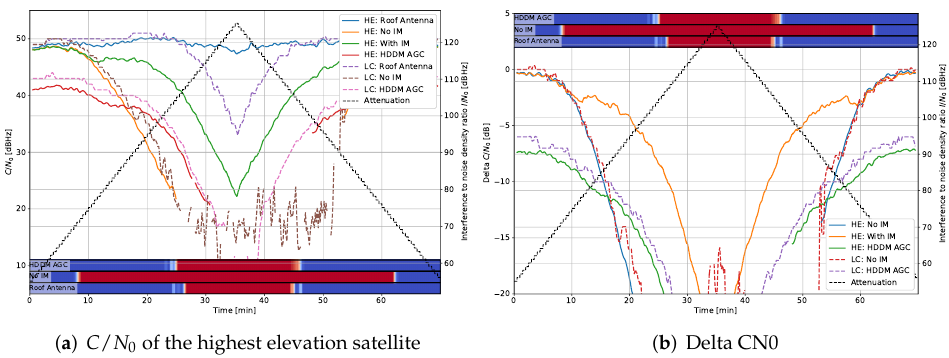
Figure A14. Interference #5: Slow frequency hopper with a dwell time of 100us and a frequency range of 35MHz with Galileo E1BC.